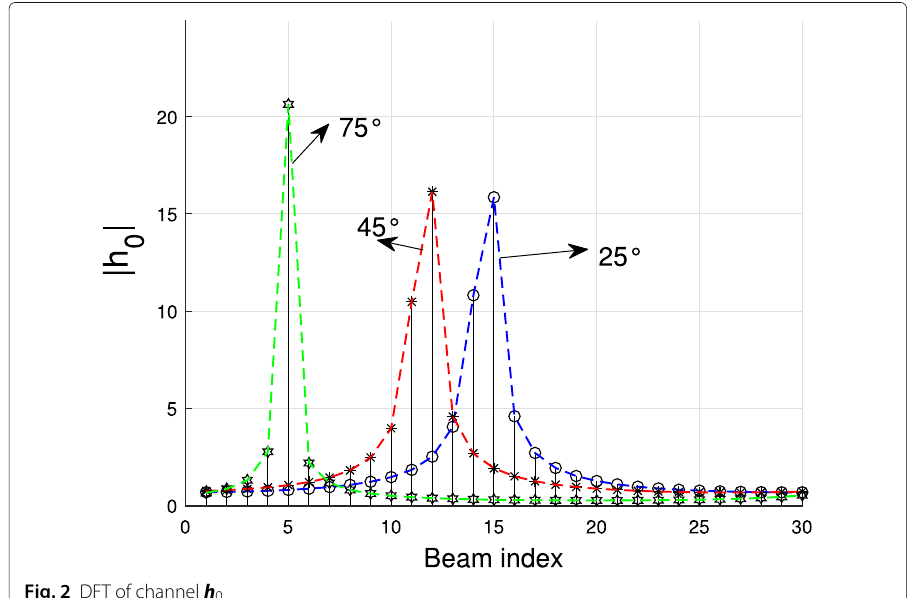
Fig. 2 DFT of channel h